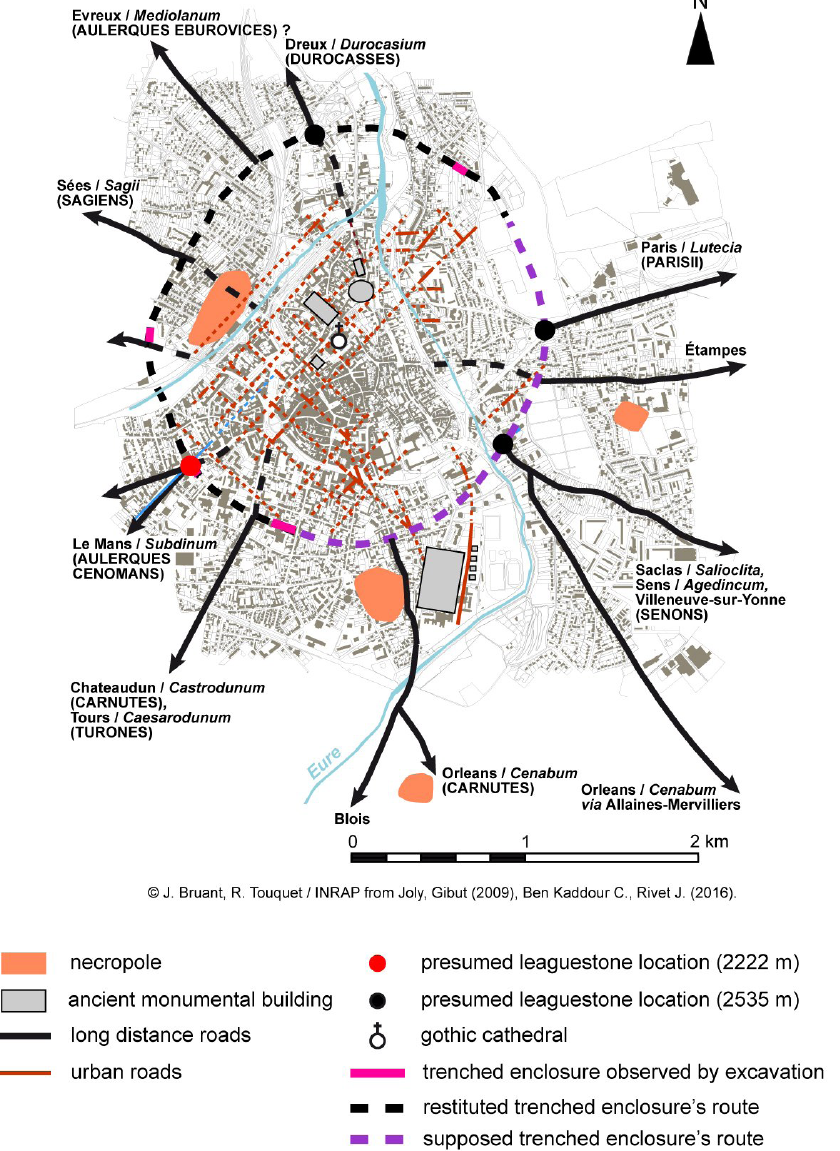
Figure 26. Presumed leaguestone location (2535 m and 2222 m systems) superimposed upon the topography of Chartres/ Autricum. © J. Bruant, R.